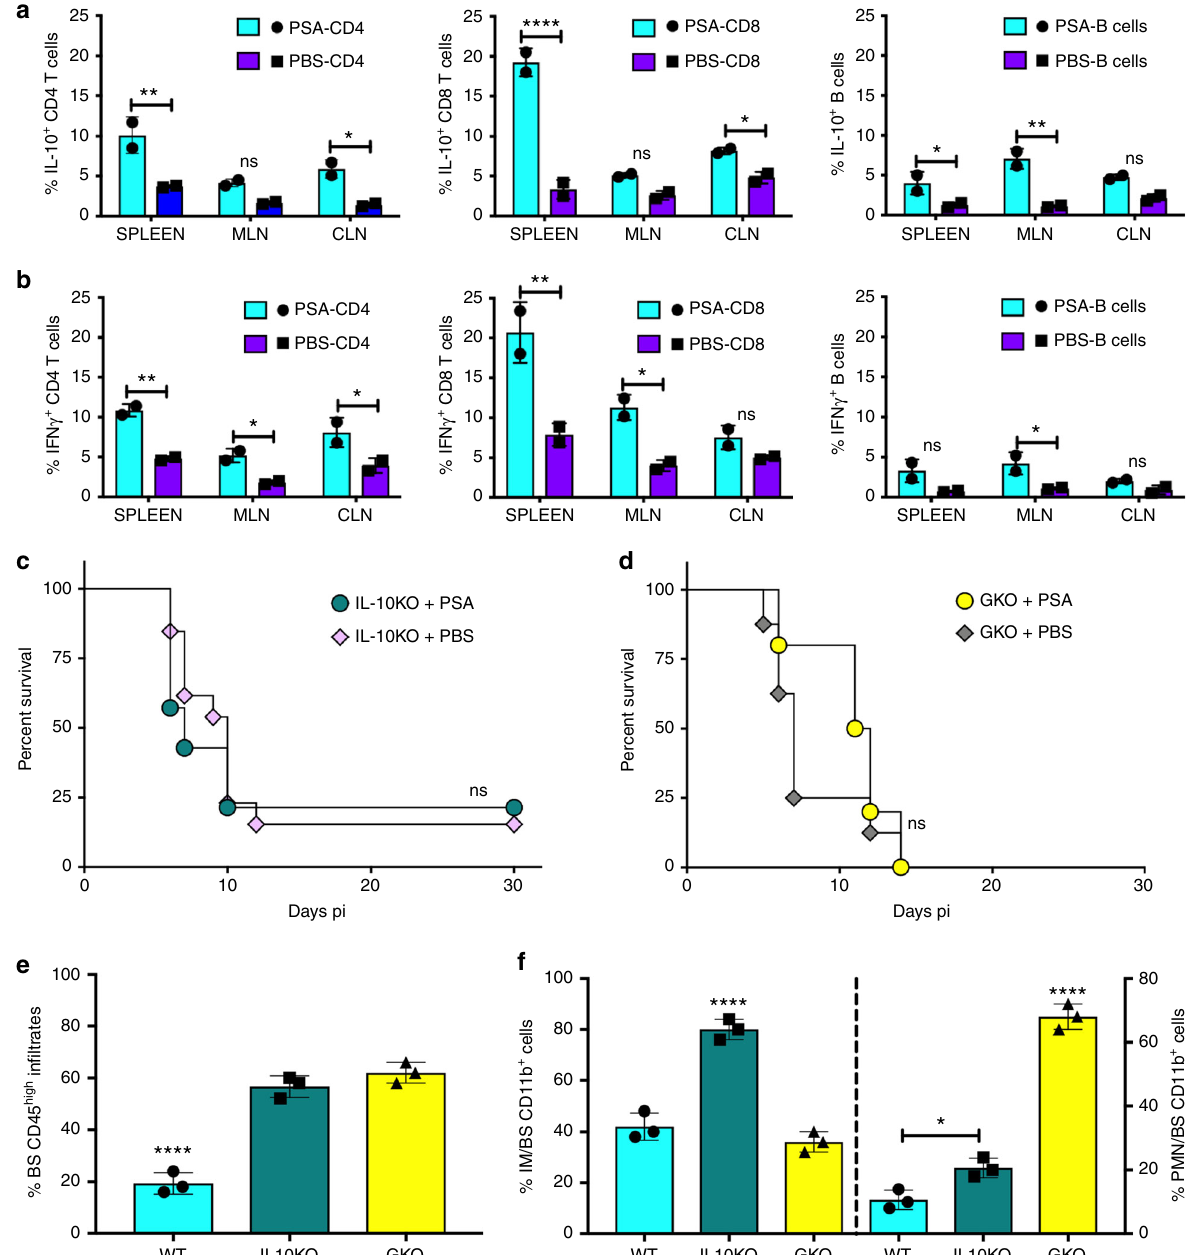
Fig. 4 PSA increases IL-10 and IFN γ -secreting T cells. CD4 and CD8 T cells and B cells in spleens, mesenteric lymph nodes (MLN), and cervical lymph nodes (CLN) of PSA or PBS-treated WT mice at day 6 pi were analyzed for a IL-10 and b IFN γ secretion, n = 2 experiments; * p < 0.05, ** p < 0.01, **** p < 0.0001, as determined by two-way ANOVA with Sidak ’ s multiple comparisons test. Survival of PSA or PBS treated c IL-10KO mice or d IFN-GKO mice ( n = 8 – 16 mice); ns: not signi fi cant. Bar plots show e % CD45 high leukocytes, f (left y -axis) % Ly6C high IM and (right y -axis) % Ly6G + neutrophils (PMN) within CD45 high CD11b + cells in fi ltrating the BS of PSA treated 129 WT, IL10KO, and GKO mice at day 6 pi, n = 3 experiments with 2 – 3 BS/group; * p < 0.05, **** p < 0.0001 as determined by ordinary one-way ANOVA with Turkey ’ s multiple comparisons IL10KO lymphocytes had similar proportions of CD45 + leuko- in the BS of the IL-10KO B cell + WT T cell recipients were cyte subsets in fi ltrating the BS of WT and IL10KO mice, neutrophils (CD45 high CD11b + in fi ltrates: 91% PMN, 5% IM, Fig. 5d). In contrast, in fi ltrates in BS of the WT B cell + IL-10KO respectively, these data are combined and shown in Fig. 4e, f. T cell recipients were dominated by Ly6C high IM (CD45 high Intriguingly, distinct in fl ammatory in fi ltrates were observed in CD11b + cell in fi ltrates: 72% IM, 16% PMN, Fig. 5e). And, while recipients of the two mixed transfer groups (Fig. 5d, e). Rag − / − similar levels of HSV gB 498 – 505 -speci fi c CD8 T cells and recipients of WT B cells and IL-10KO T cells (green) had ~68% CD45 high in fi ltrates in the BS compared to ~51% in fi ltrating ICOS + CD4 + T cells were observed in both mixed transfer CD45 high leukocytes for recipients of (brown) IL-10KO B cells groups, they expressed a highly activated (CD44 high ) effector and WT T cells (Fig. 5d, e). The majority of CD45 high in fi ltrates T cell phenotype in the spleen (Supplementary Fig. 5d). These